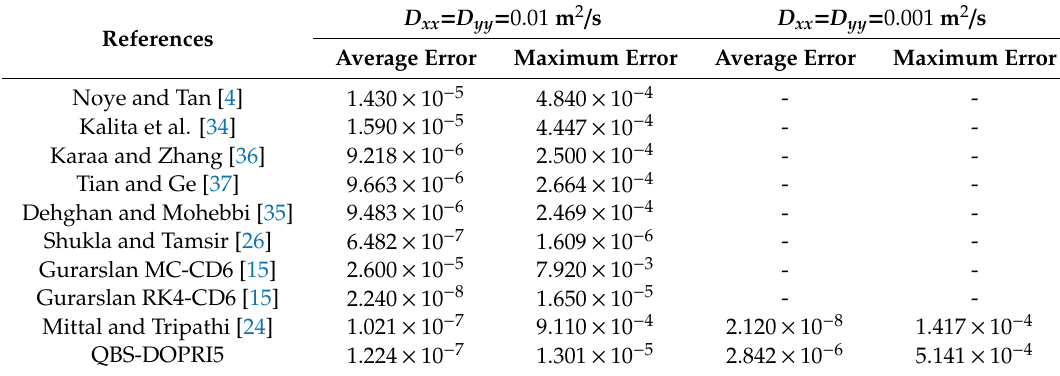
Table 5. Comparison of average absolute error and maximum absolute error values obtained at